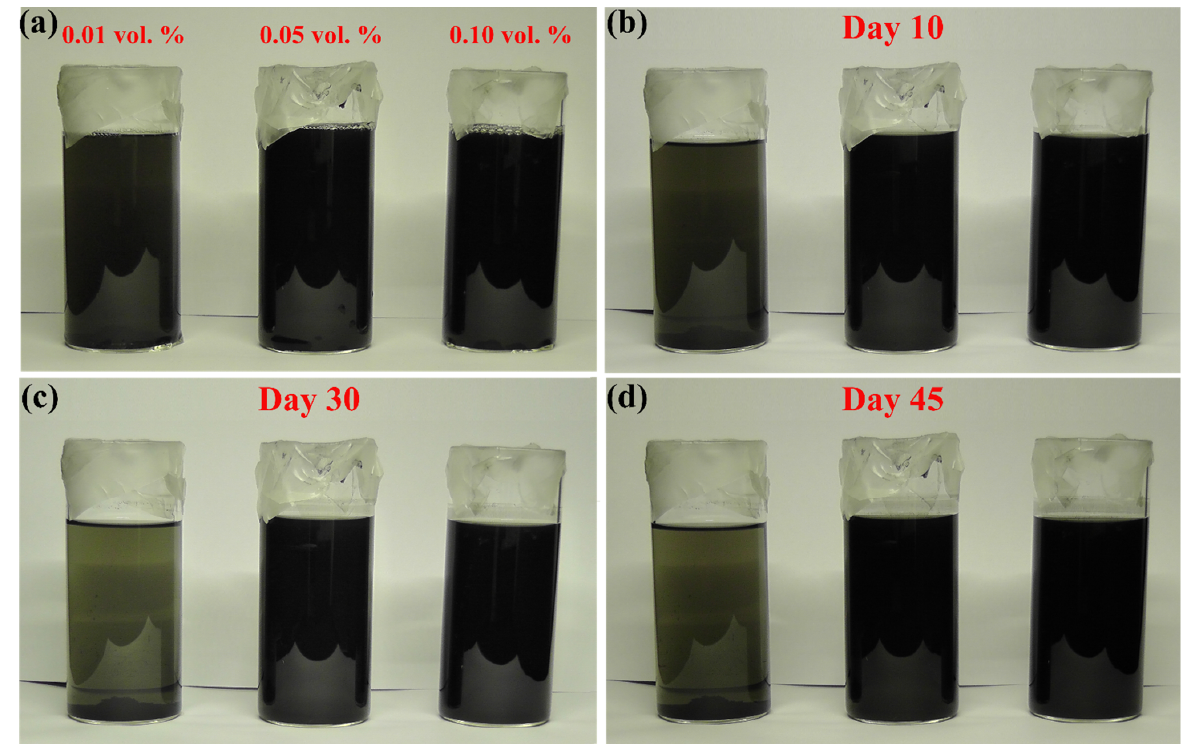
Figure 5 . Image of the 30 °C controlled temperature as-prepared MWCNTs-based nanofluids, where ( a ) are the samples directly after production, ( b – d ) on days 10, 30, and 45, respectively.